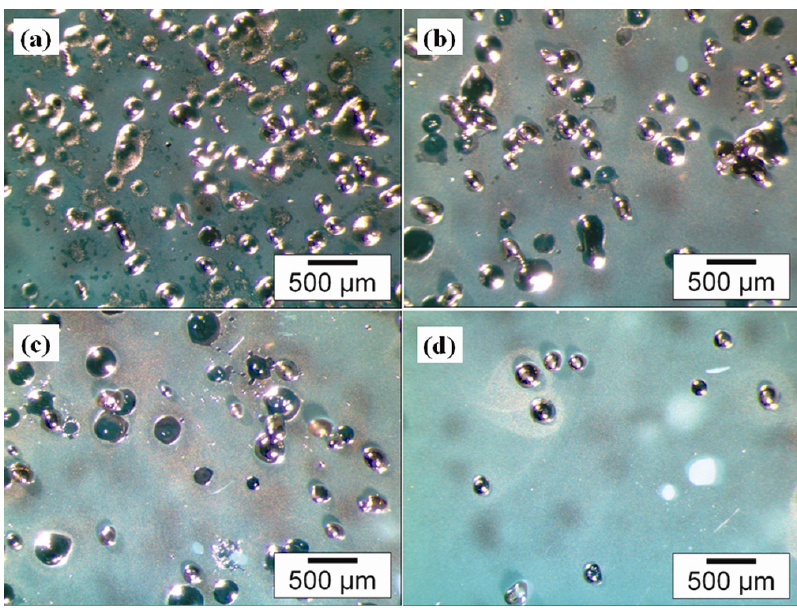
Figure 8. Stand-off distance (SOD) effect on microstructure of splat and splash splat on glass substrates.